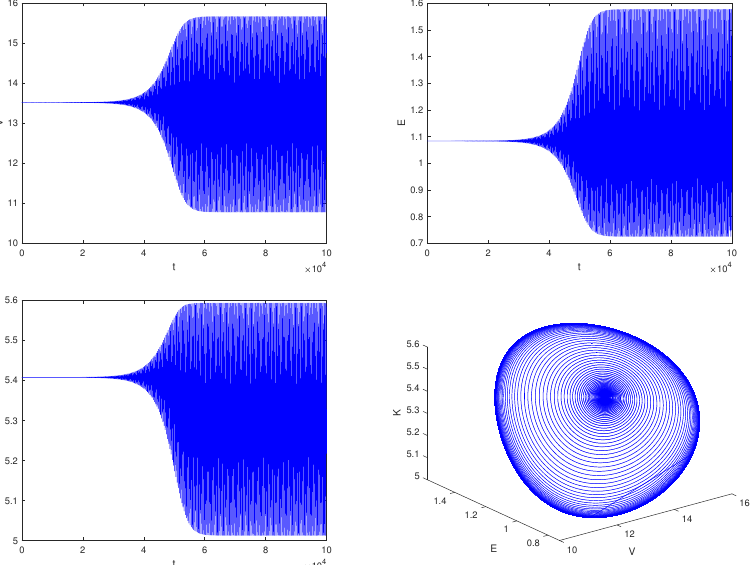
Figure 4. The phase graph and the trajectories of system ( 4 ) with τ 1 = 1.00, τ 2 = 2.55, S ∗ is unstable, from S ∗ bifurcates a stable periodic